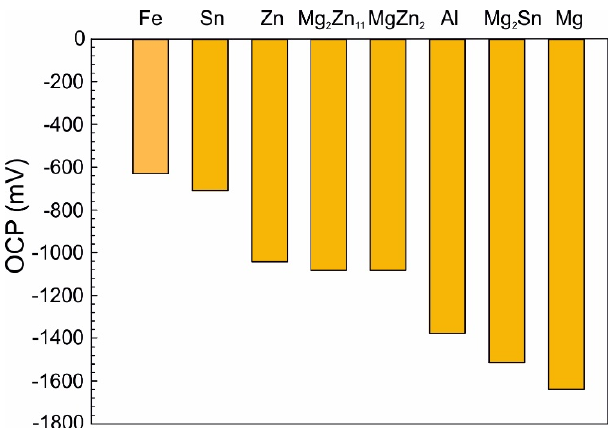
Figure 13. Overview of OCP values for phases present in the investigated system